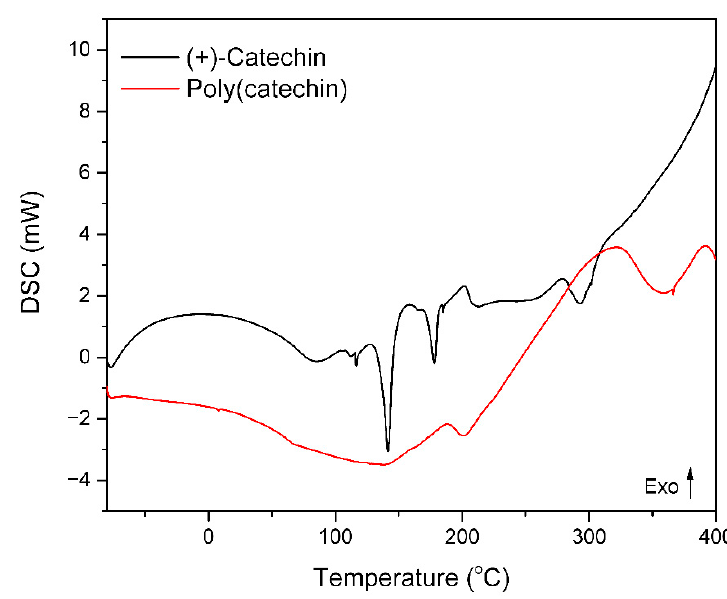
Figure 3. DSC thermograms of (+)-catechin and poly(catechin). The (+)-catechin thermogram showed two endothermic peaks corresponding to the melting of the sample and exothermic peak related to oxidation and degradation of flavonoid. On the thermogram of poly(catechin) were also found endtothermic peak corresponding to the melting of the material and an exothermic peak of oxidation associ- ated with the decomposition of the poly(catechin). Both tested samples did not have the glass transition temperature T g .